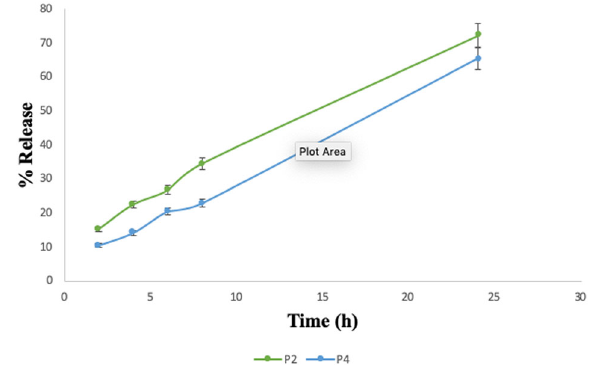
Fig. 2 % Drug release pro fi les of retinoic acid from polyplex for- mulations P2 and